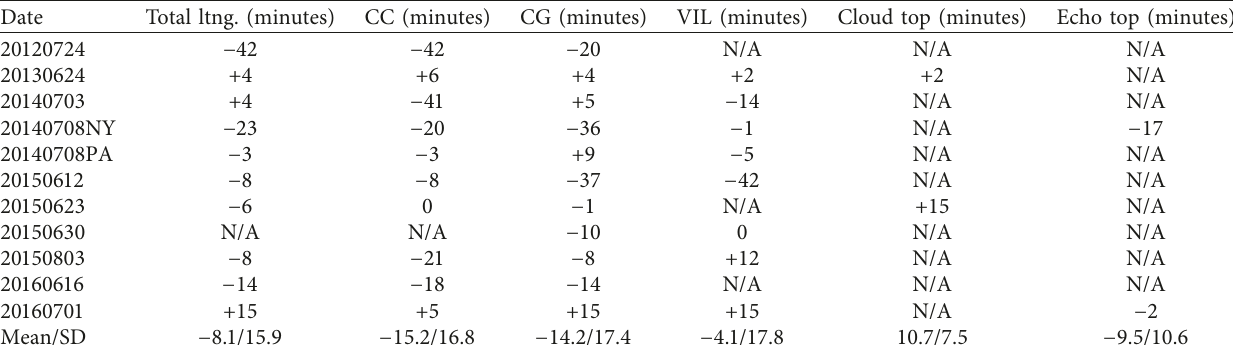
Table 3: Time of 2 σ maxima of each parameter with respect to the